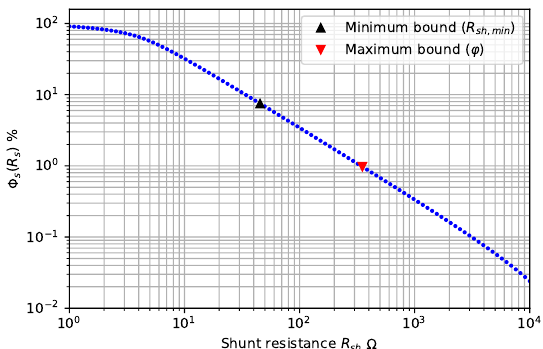
Figure 7. Behavior of Φ sh ( R sh ) for a test SPVM. It is indicated the minimum and maximum